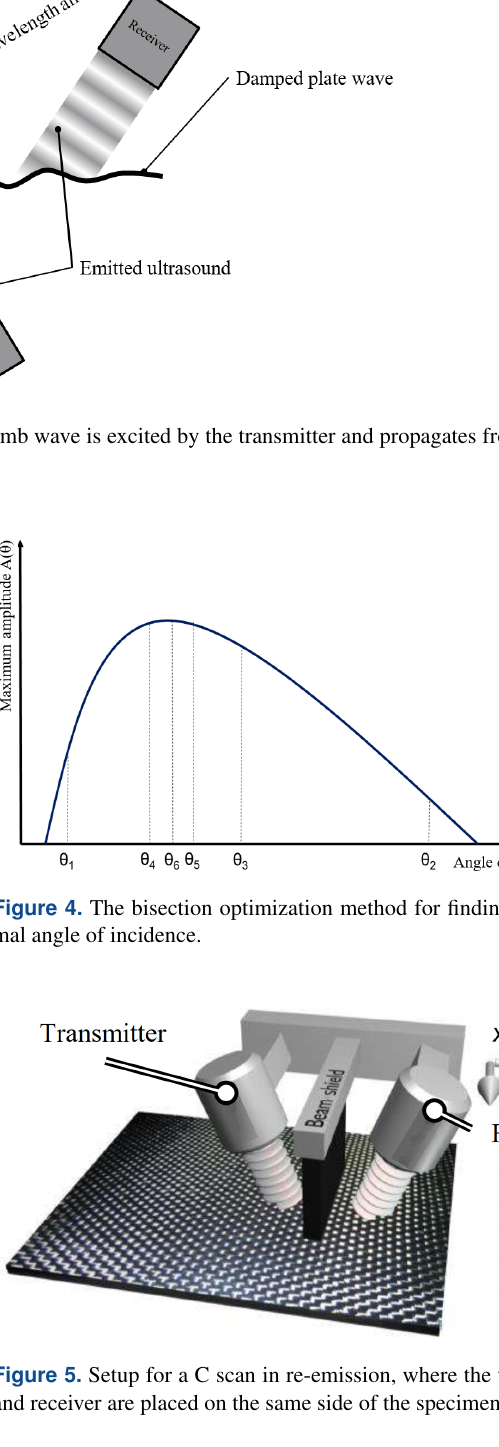
ning line by line over a specific area and color-coding the amplitude level in an x – y plot, a defect map is successively created. These color maps are called a C scan. In Fig. 5 the setup for C scans in re-emission is